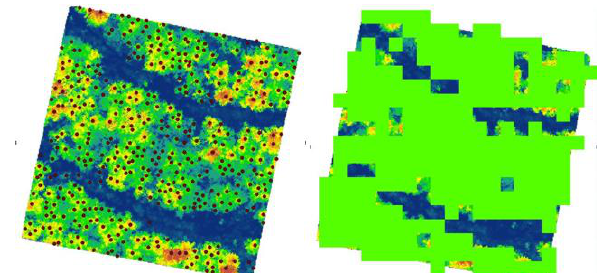
Figure 6. Filling of the growing space in the